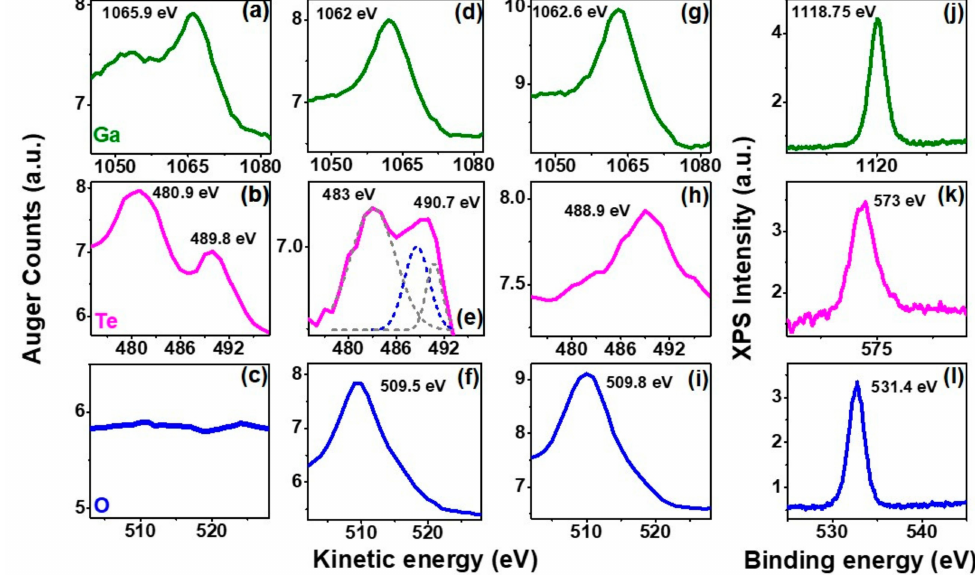
Figure 4. Auger spectra of Ga, Te, and O, respectively, ( a – c ) for a 55 nm HSQ-capped GaTe flake exposed to ambient air for 43 days; ( d – f ) for a 68 nm uncapped GaTe flake exposed to ambient air for 20 days; ( g – i ) for a 190 nm flake exposed to ambient for 5 months and subsequently annealed at 300 ◦ C for 30 min in argon ambient. The deconvoluted peak at ~488 eV (blue) shown in (e) belongs to the KL 1 L 23 Auger transition for oxygen bonded to gallium in GaO x . XPS spectra of Ga, Te, and O, respectively, ( j – l ) for an uncapped ambient-exposed GaTe